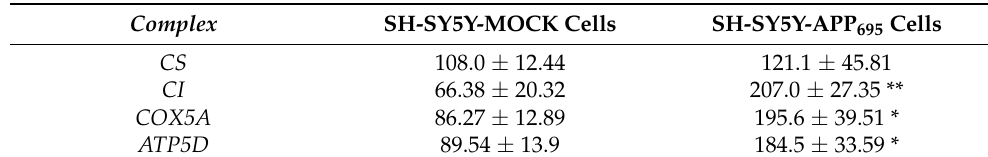
Table 3. Effect of HstN at relative normalized mRNA expression levels in SH-SH-SY5Y-MOCK and -APP 695 cells after incubation with HstN for 24 h, determined using quantitative real-time PCR compared to SH-SY5Y cells incubated with PlantaCare (PC). mRNA expression of control cells incubated with PC is set as 100%. Respective mean values ± SD are shown. Significance was determined with unpaired Student’s t-test (* p < 0.05, ** p < 0.01). Calculation of normalization factor based on geometric mean of multiple control genes levels of ß-actin ( ACTB ), glyceraldehyde 3-phosphate dehydrogenase ( GAPDH ), and phosphoglycerate kinase 1 ( PGK1 ). HstN, hesperetin nanocrystals.